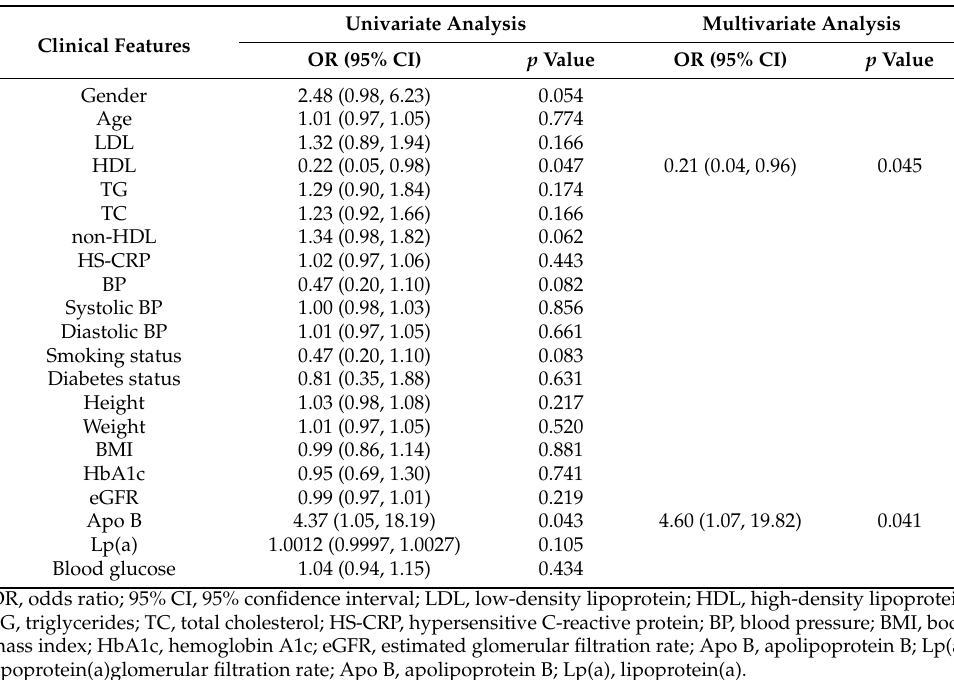
Table 3. Candidate predictors of three-dimensional ultrasound of carotid plaque after logistic re- gression analysis. Three-Dimensional Ultrasonic Features